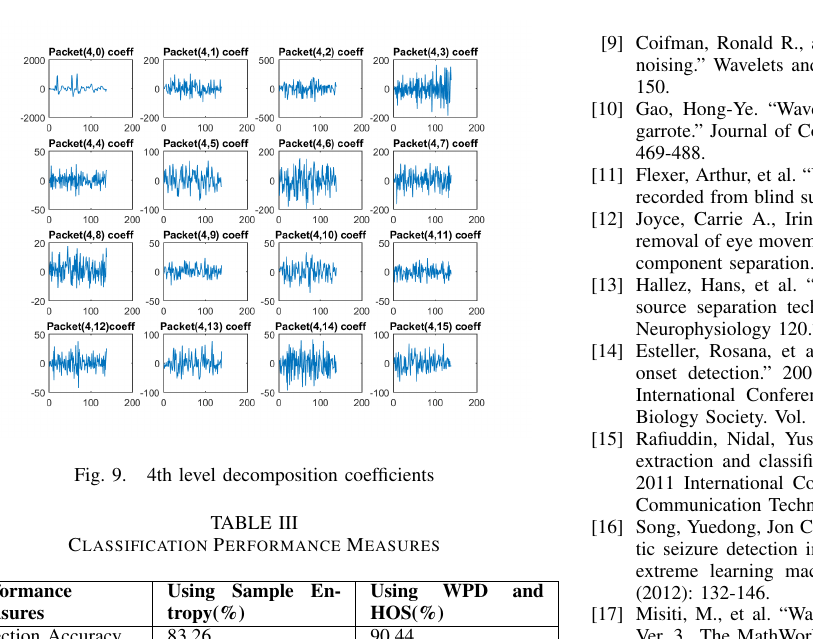
Fig. 4. Artifactual Data and Reconstructed Data